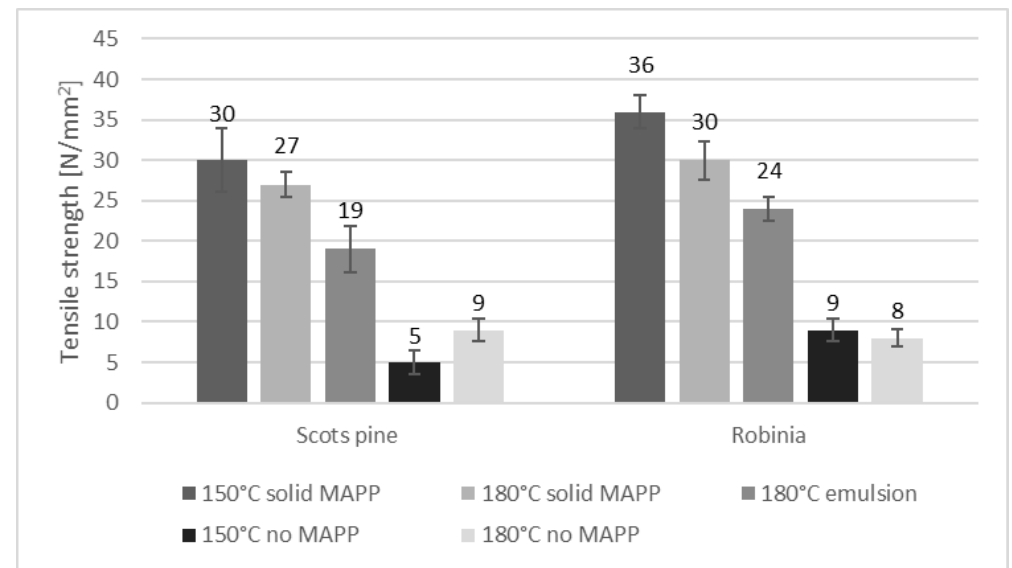
Figure 3. Tensile strength of composites with TMP based on Scots pine or Robinia. For comparison, tensile strength of composites with wood flour (softwood) was 41 N/mm 2 including MAPP (solid) and 11 N/mm 2 excluding